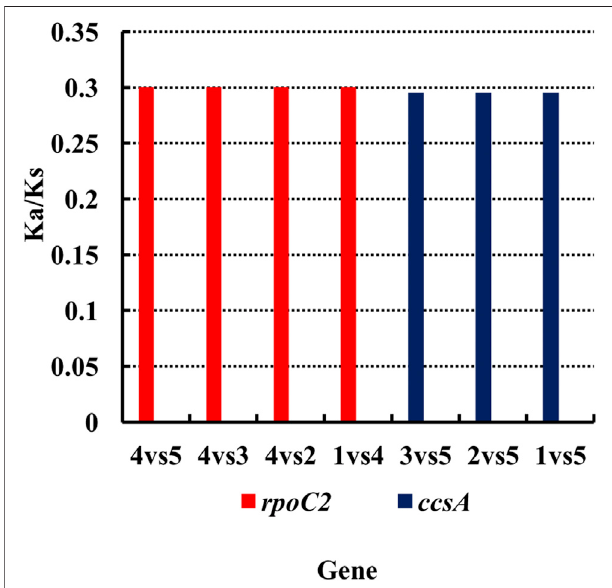
FIGURE3| AnalysisoftheKa/Ksratioof Agropyron . X -axis:nameofthe gene. Y -axis: value of Ka/Ks. 1 – 5: A. cristatum × A. desertorum Fisch. Schult, A. desertorum , A. desertorum Fisch. Schult, A. michnoi , and A. mongolicum . The red bars indicate the rpoC2 gene, and the blue bars indicate the ccsA gene.